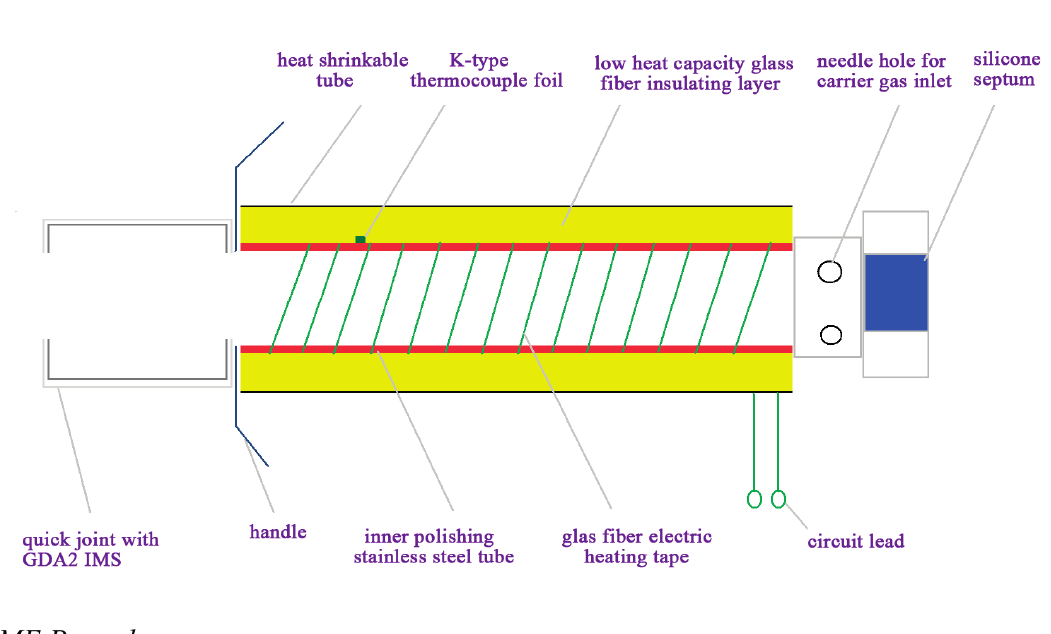
Figure 1. The primary components and constructional details of the self-made